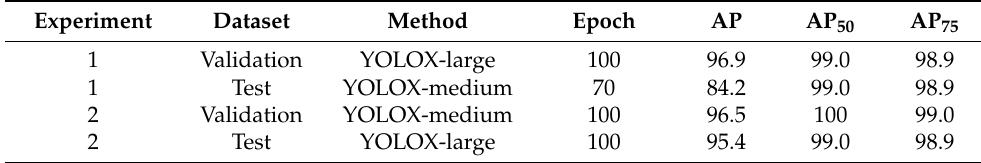
Figure 5. Performance metric AP on ( a ) validation set—experiment 1. ( b ) Validation set—experiment 2. ( c ) Test set—experiment 1. ( d ) Test set—experiment 2. Table 3. Best performance of YOLOX methods evaluated by AP.